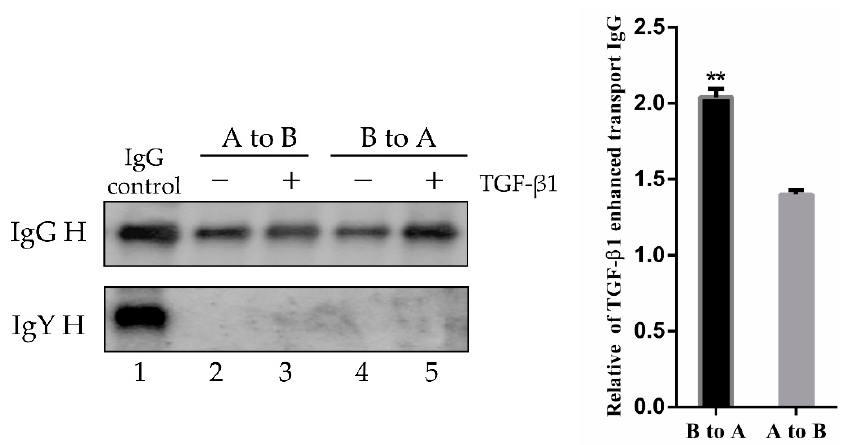
Figure 5. Effect of TGF- β 1 stimulation on IgG bidirectional transcytosis. A, apical; B, basolateral. IPEC-J2 cells were cultured on 12-well Transwell plates (0.4 µ m pore size) for 6–7 days, until TEER > 1000 Ω /cm 2 . IPEC-J2 cells were incubated with or without TGF- β 1 (8 ng/mL) for 12 h. Porcine biotin-IgG or biotin-IgY were added to the apical chamber (lanes 2 and 3) or basolateral chamber (lanes 4 and 5) and incubated for 3 h at 37 ◦ C. Lane 1 corresponds to IgG, ** p <